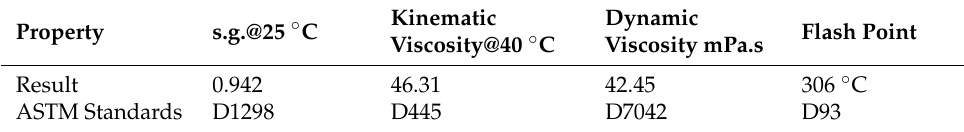
Figure 2. Samples of the used noncommercial additives. Table 7. Physical characteristics of WCO.